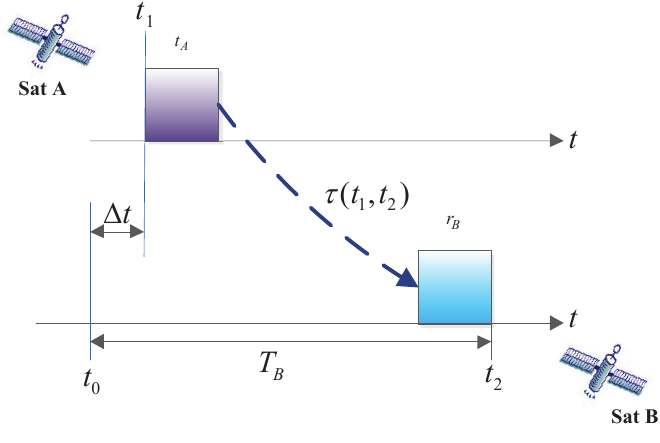
Figure 1. One-way pseudo-range measurement process.